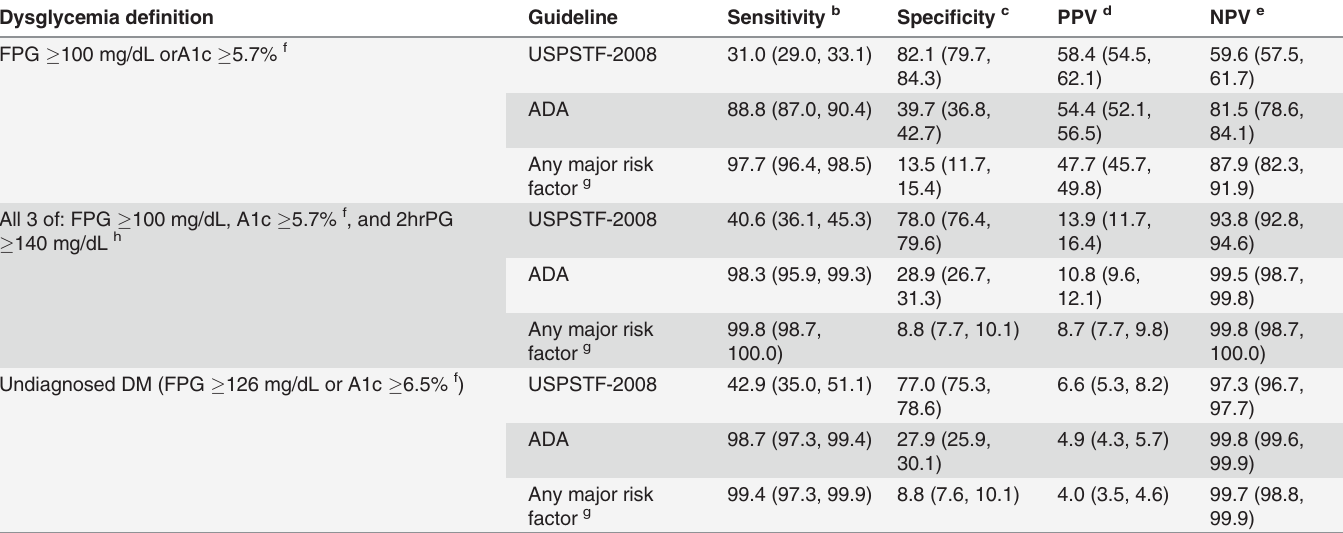
Table 4. Performance a of screening criteria in identifying dysglycemia among US adults without diagnosed diabetes. Dysglycemia de fi